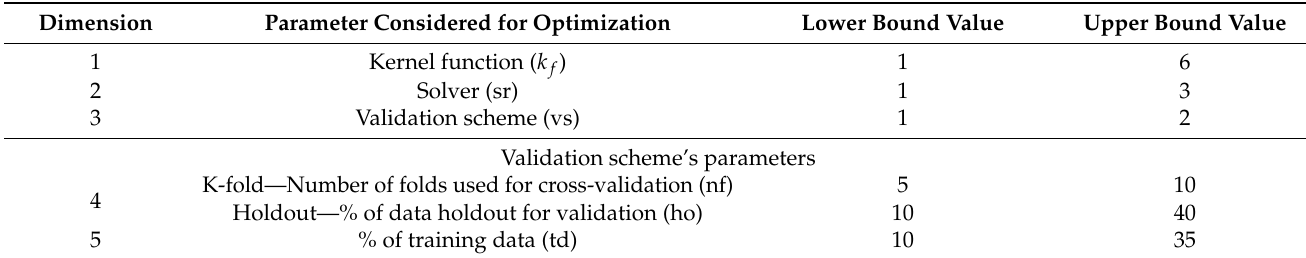
Table 5. Parameters of MFO, DFO and PSO algorithms [24].